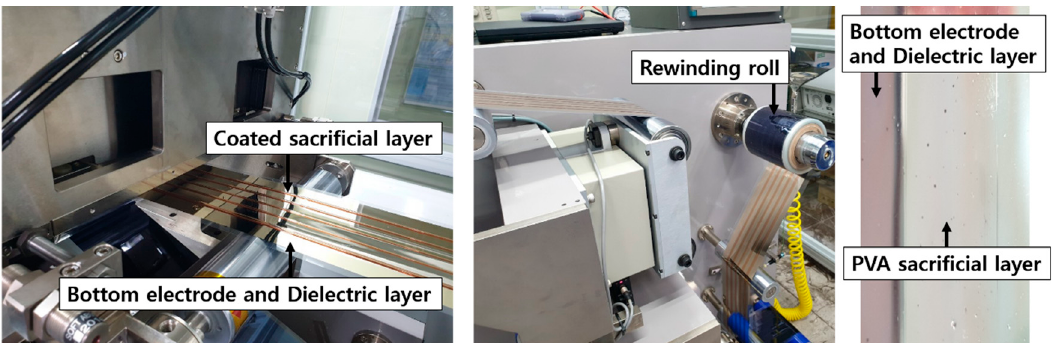
Figure 4. Roll-to-roll slot-die coating process: a coated sacrificial layer ( left ); rewinding of the sacrificial layer ( middle ); and of a sample of the sacrificial layer ( right ).